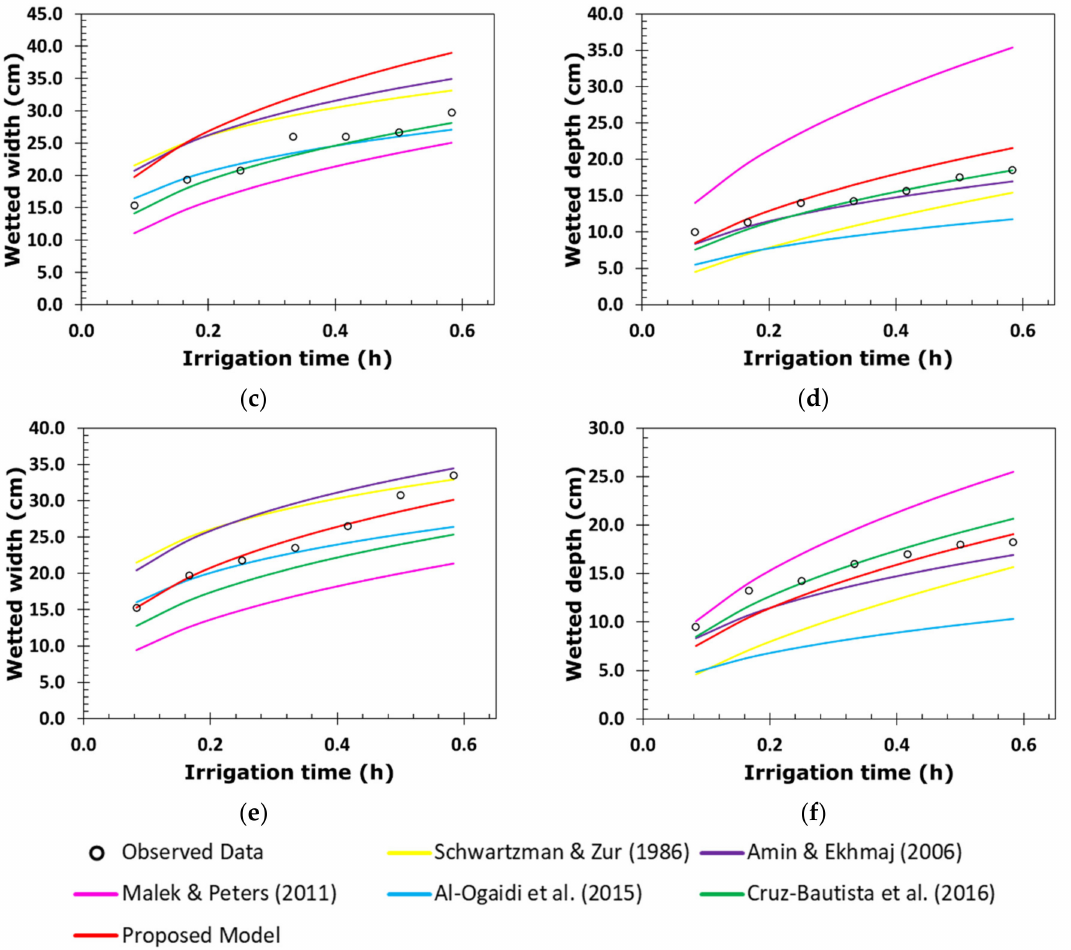
Figure 8. Temporal evolution of the width and depth of the wetting front of ( a , b ) irrigation 1B (q = 4.00 L h − 1 and θ i = 0.09 cm 3 cm − 3 ), ( c , d ) irrigation 3B (q = 4.00 L h − 1 and θ i = 0.10 cm 3 cm − 3 ), and ( e , f ) irrigation 5B (q = 4.00 L h − 1 and θ i = 0.13 cm 3 cm − 3 ) [6,10,12,13,24].